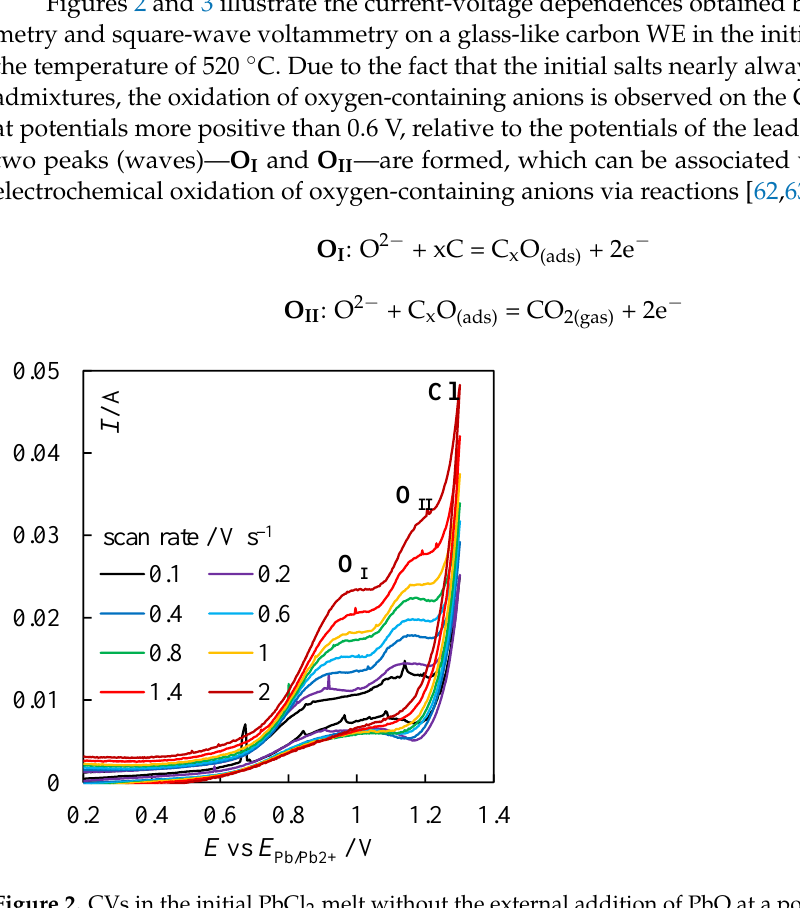
Figure 3. SWV in the initial PbCl 2 melt without the external addition of PbO at a potential reverse frequency of 25 Hz, potential sweep rate of 0.1 V s −1 and a temperature of 520 °C. To choose the parameters of the following measurements and to determine the na- ture of the limiting stage of the studied electrochemical process, the voltammetry depend- ences were recorded at different potential sweep rates (Figure 2). It is seen that the poten- tials of O I and O II remain almost unchanged, and the current peaks grow as the potential sweep rate increases. This elucidates that processes (1) and (2) are reversible, and the dif- fusion of the oxygen-containing ions from the melt volume to the WE surface is the limit- ing factor. In this case, the value of the current peak in a certain interval will be linearly